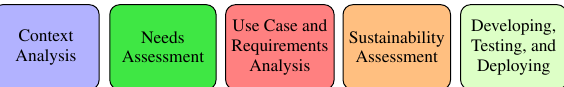
Figure 2. The five components of the ICT4D Framework adapted from Bon et al. (2016).